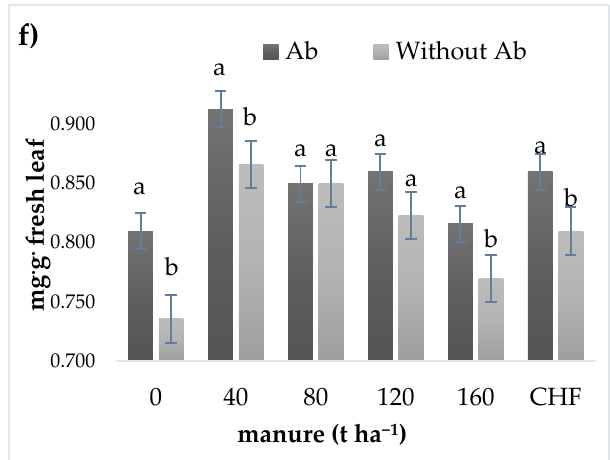
Figure 2. Interaction of Ab–Fertilization in content of protein in root ( a ), protein in stem ( b ), lipid in root ( c ), lipid in stem ( d ), lipid in leaf ( e ) and chlorophyll b ( f ). Ab: Azospirillum brasilense ; 0, 40, 80, 120, 160 = manure t . ha −1 ; CHF: chemical fertilization. Different literals in the bars indicate significant difference with p < 0.05.